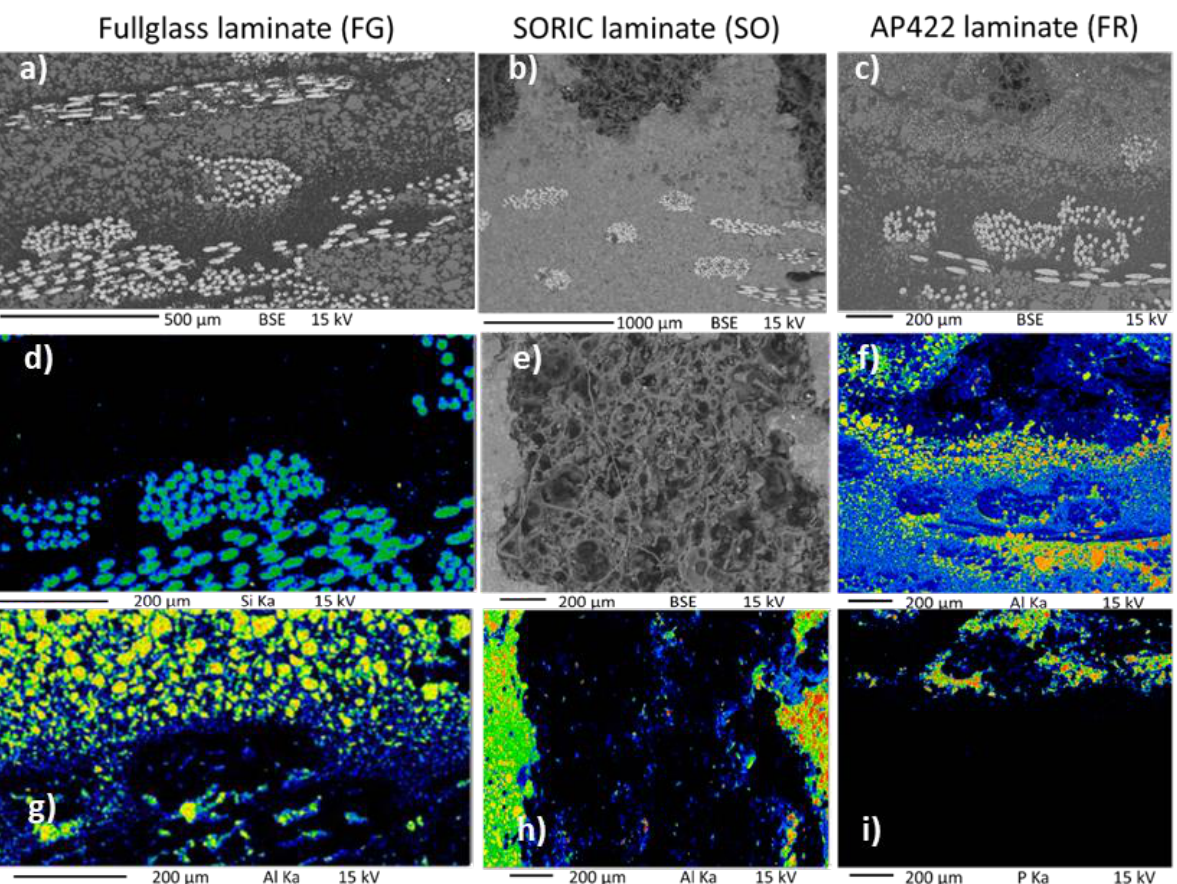
Figure 4. BSE pictures and elemental mappings of the different laminates obtained from EPMA. The first column concerns the full-glass laminate and provides ( a ) the BSE picture, ( d ) the Si and ( g ) the Al mapping. The second column shows the characterization of the untreated SOIRC sandwich with ( b ) showing a BSE picture of the interface between the core material and the glass skin, ( e ) showing a BSE picture of a pattern of the SORIC that is not filled by the resin and ( h ) showing the corresponding Al mapping. In the third column, the data are from the laminate containing AP422-treated SORIC. ( c ) presents the BSE picture of the interface of the treated SORIC and the glass skin, ( f ) the corresponding Al mapping and ( i ) the corresponding P mapping.